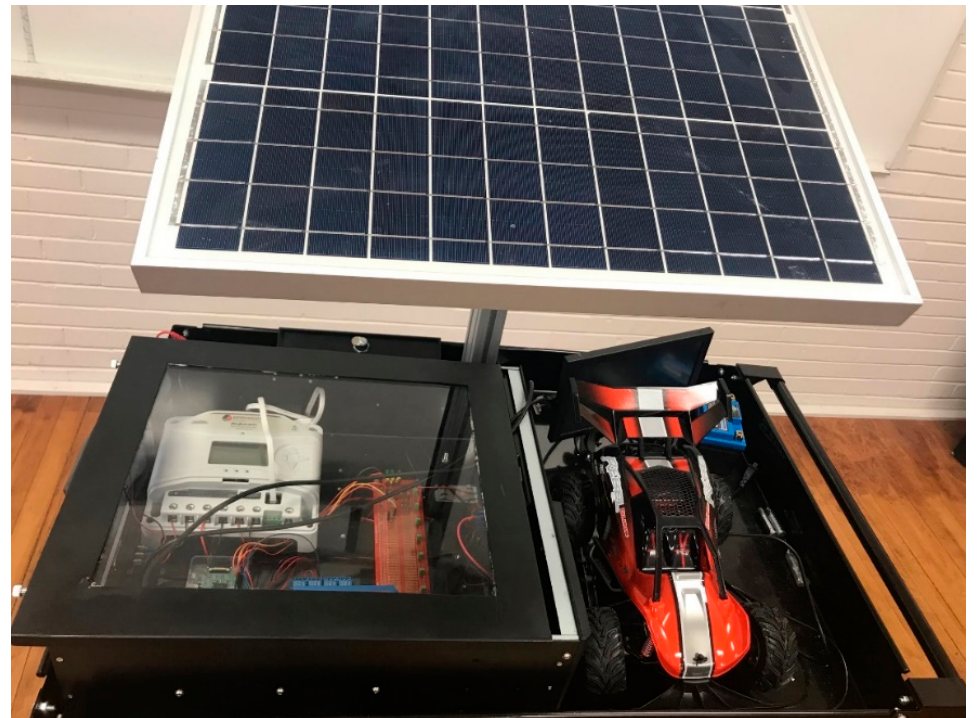
Figure 4. Solar Microgrid Hardware. Table 1. List of Materials and Cost.